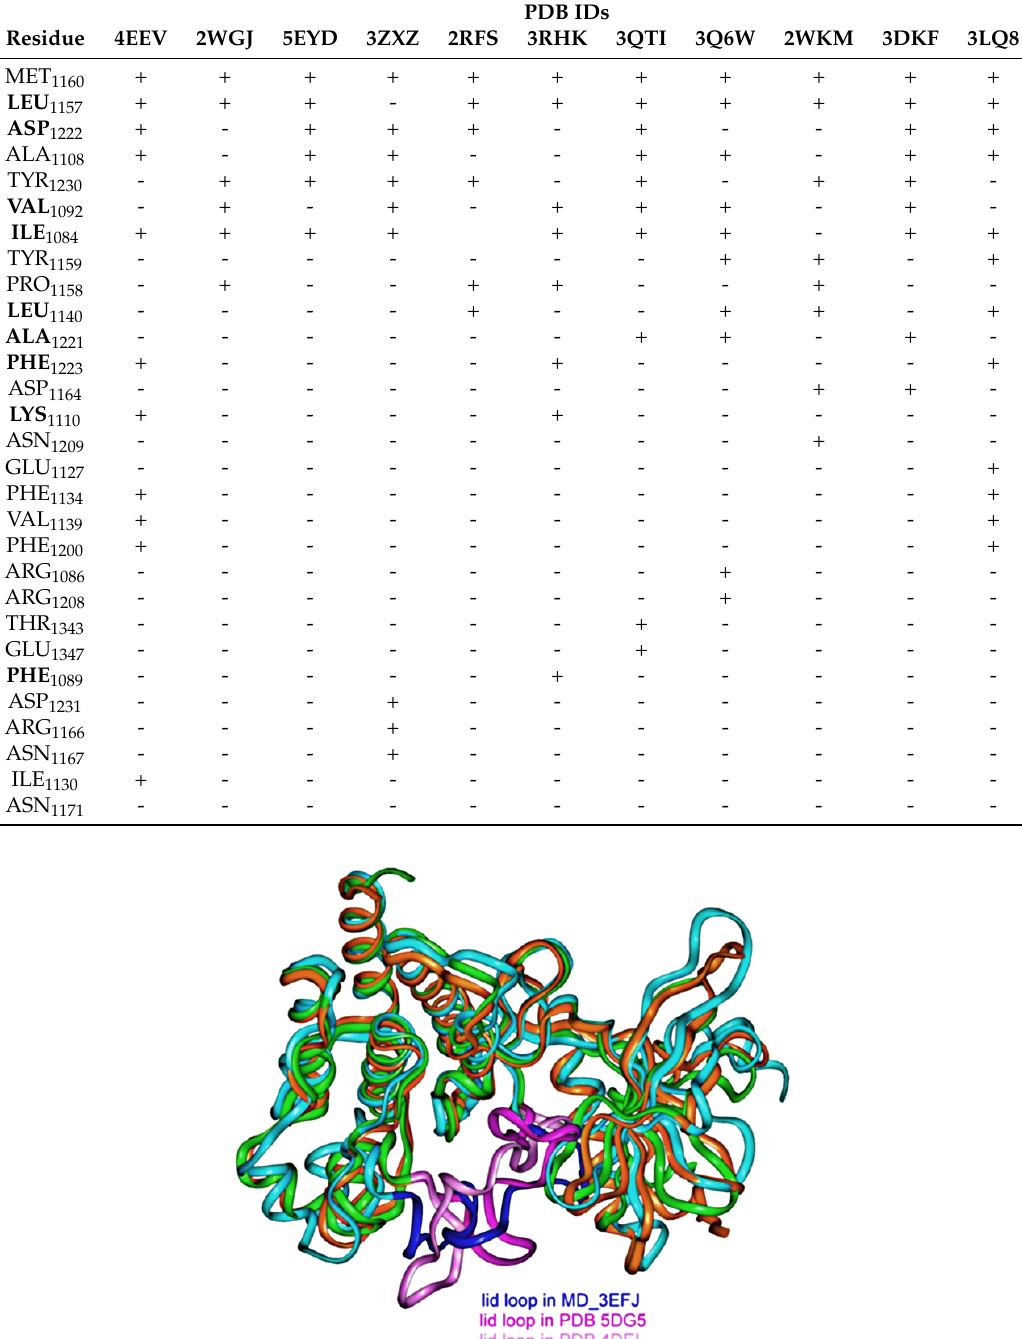
Table 8. List of the protein residues interacting with a nM. inhibitor from the PDB complexes of Table 7 ranked by their number of occurrence. In bold, the residues also found in the interactions with F0514-4011 with the MD-3EFJ MET conformation. According to the PLIP results, a residue was marked ”+“ when at least one protein-ligand interaction was found, whatever its quality (hydrophobic, H-bond, π -stacking, ionic, etc.) and marked by ”-“ when no protein-ligand interaction was found.